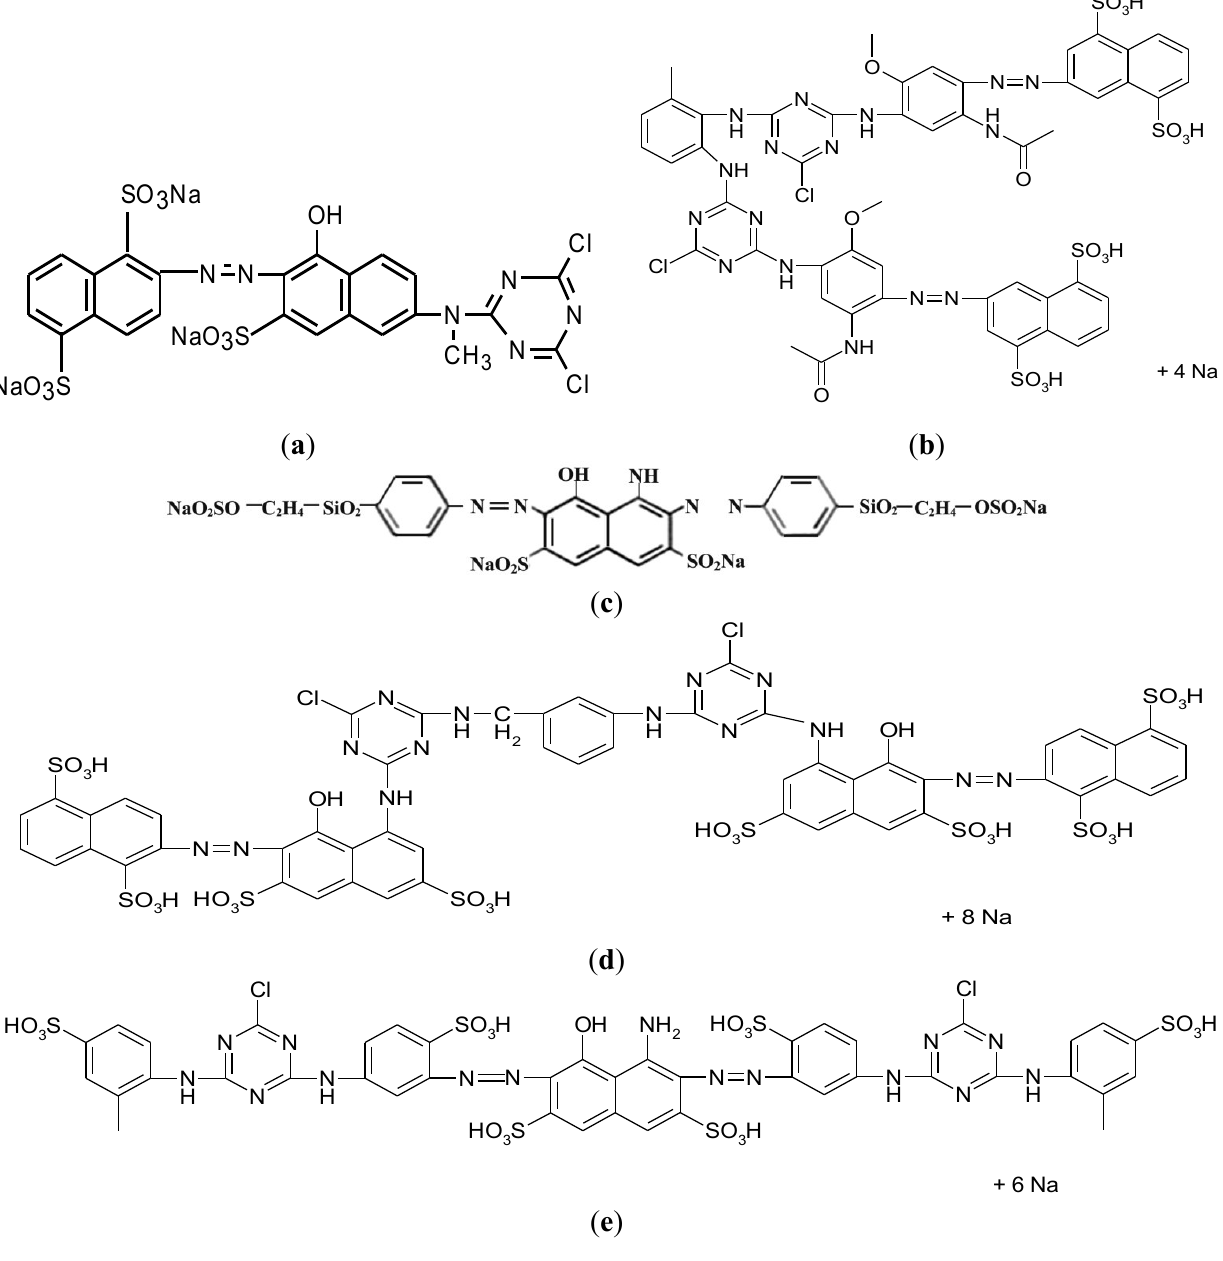
Figure 5. Chemical structure of ( a ) PMX2R; ( b ) PY; ( c ) RB5; ( d ) PC; ( e )